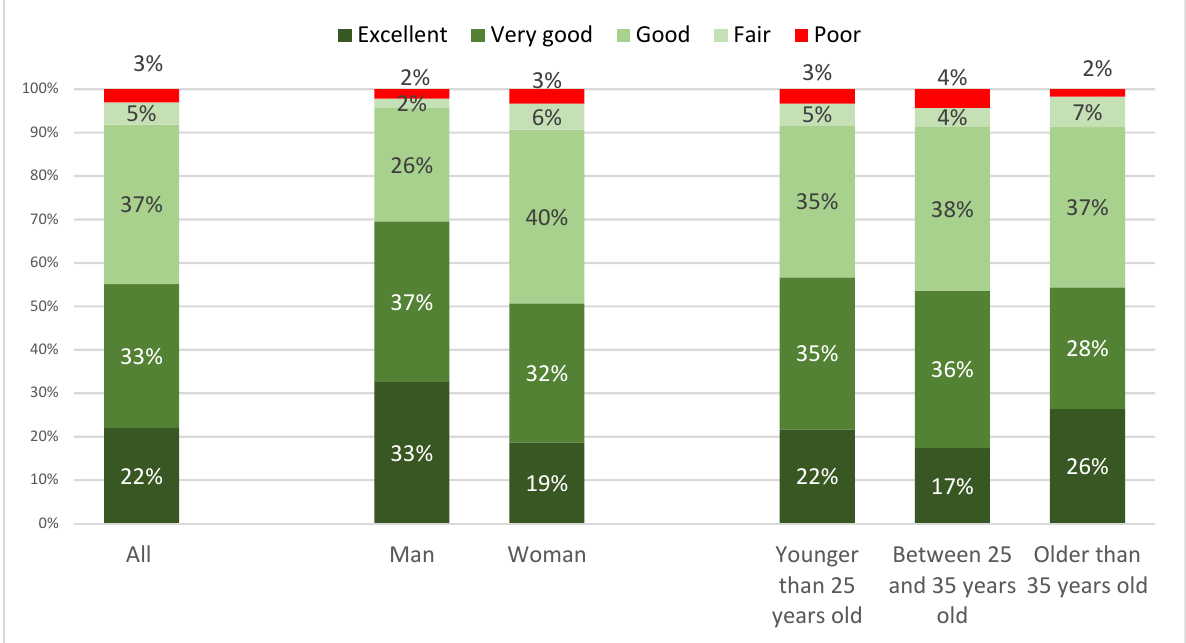
Figure 1. Resilience (CD-RISC 2), by gender and age group, by percentage. (Note. Scaling from 0 ‘Not true at all’ to 8 ‘True nearly all the time’).